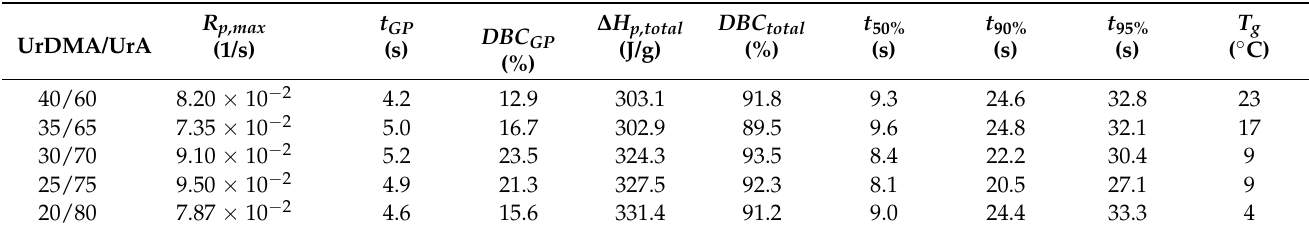
Table 3. Photo reactivity of UrDMA/UrA mixtures containing 1 wt.% TPOL under N 2 atmosphere at 25 ◦ C obtained from photo-DSC